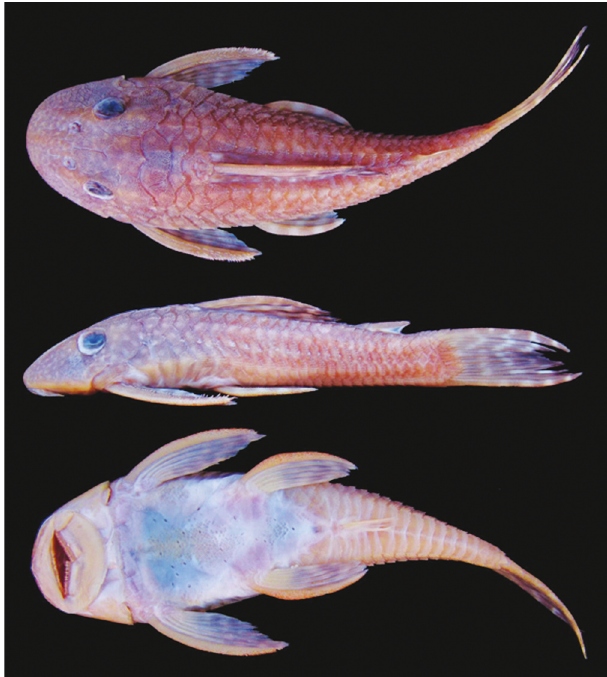
Fig. 1. Dorsal, lateral and ventral views of Hypostomus strigaticeps . MZUSP 79646, Tietê River, São Paulo State, Brazil. 127.6 mm